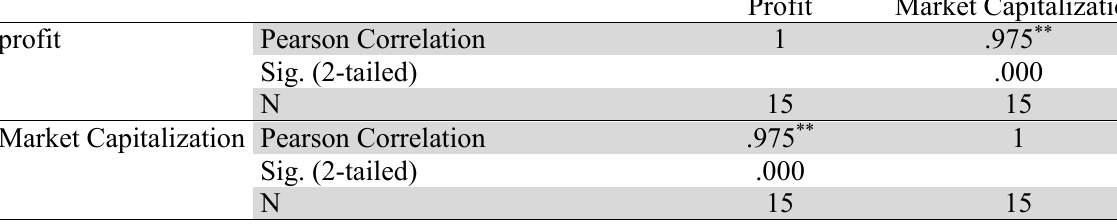
Correlation between Profitability and market capitalisation in selected companies